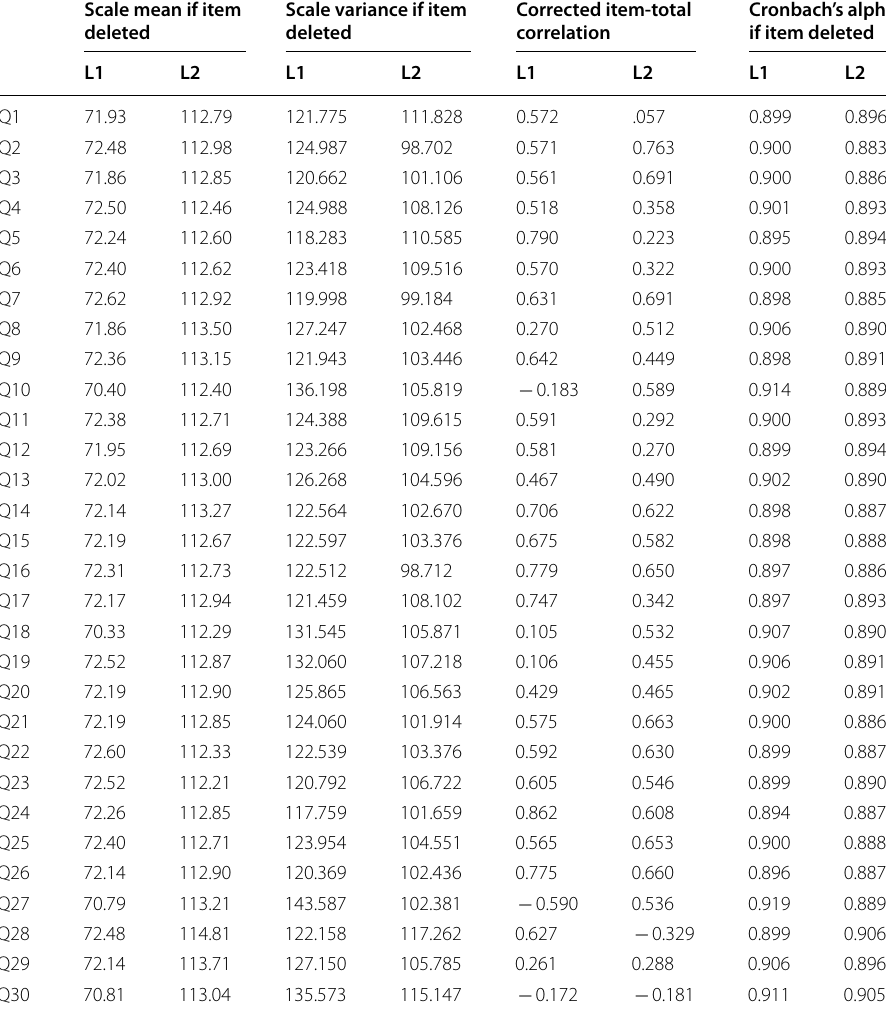
Table 3 Item‑total statistics for L1 and L2 questionnaires